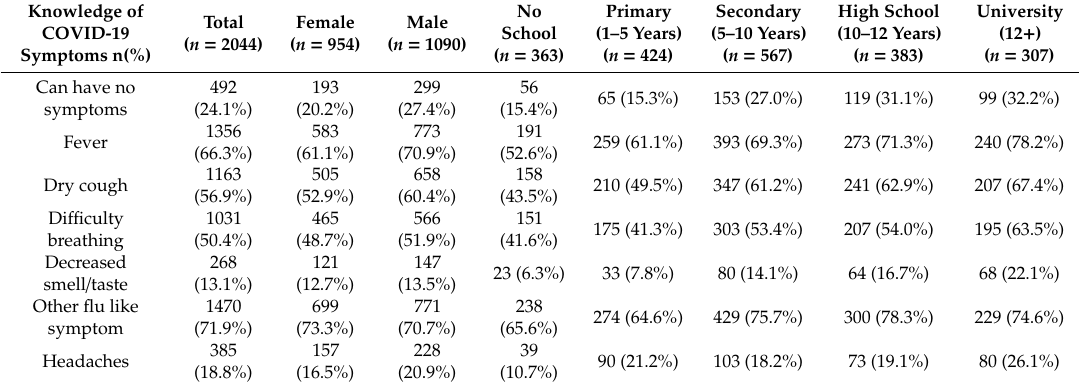
Table 1. Awareness of COVID-19 symptoms by gender and education, Tamil Nadu, India, May